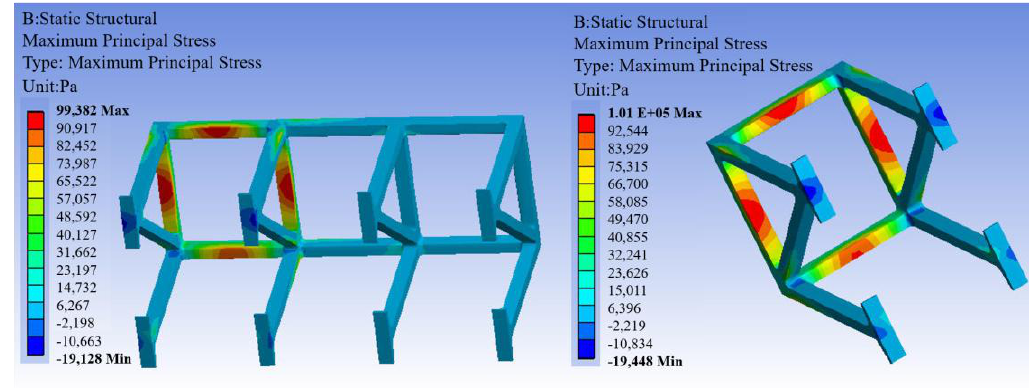
Figure 25. Stress analysis for comparison of the support parts between redesign and the traditional